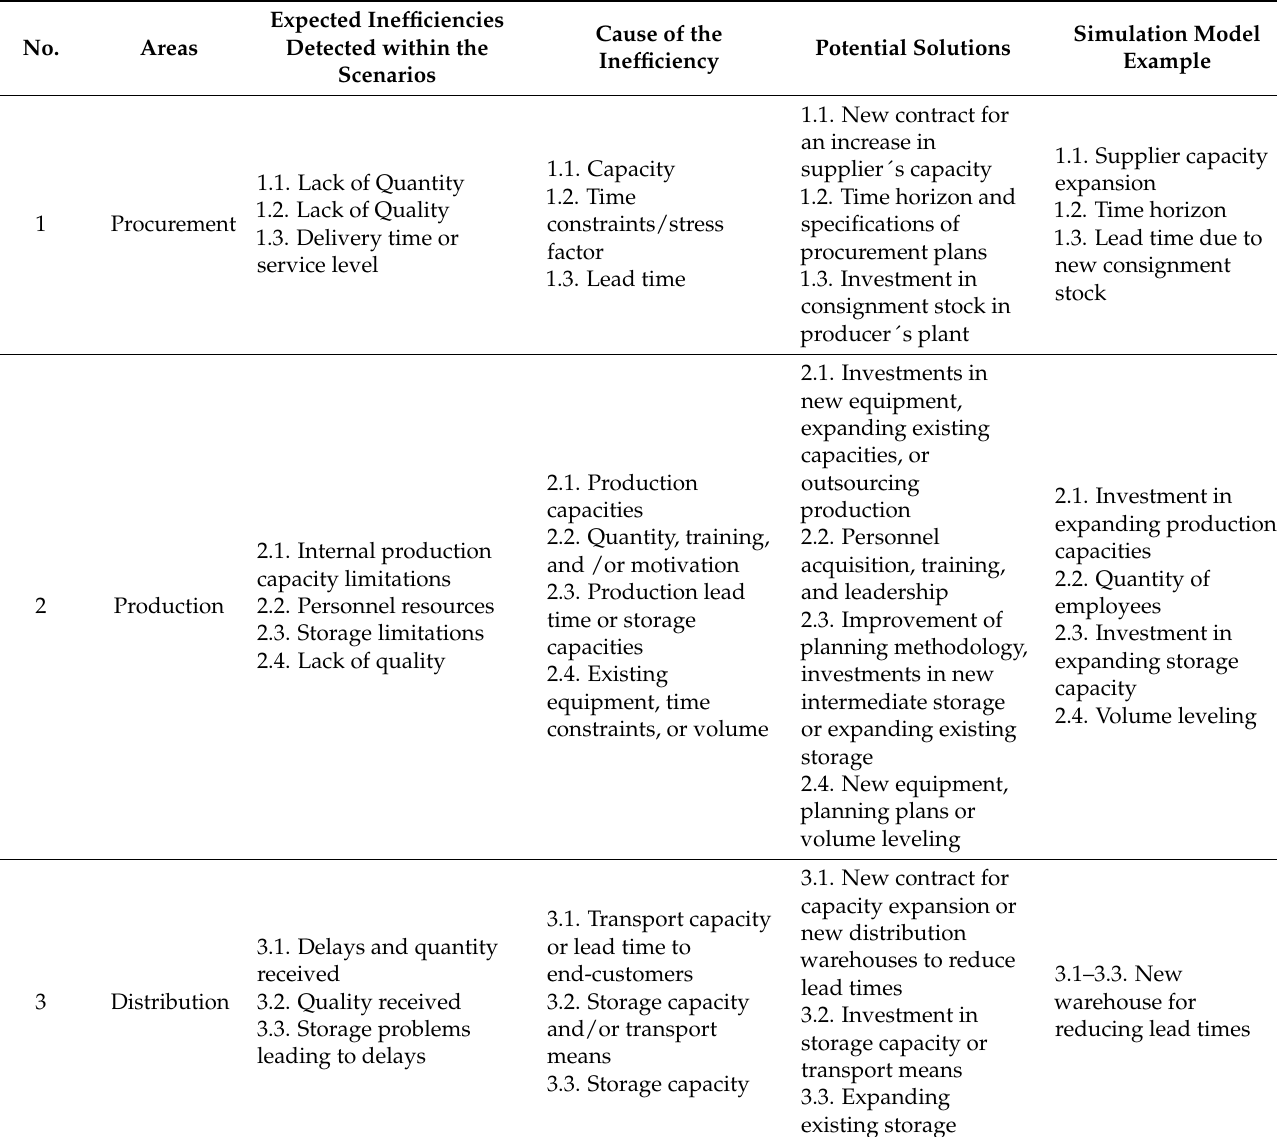
Table 1. Predictions to avoid corrections: from inefficiencies towards solutions within the supply chain.